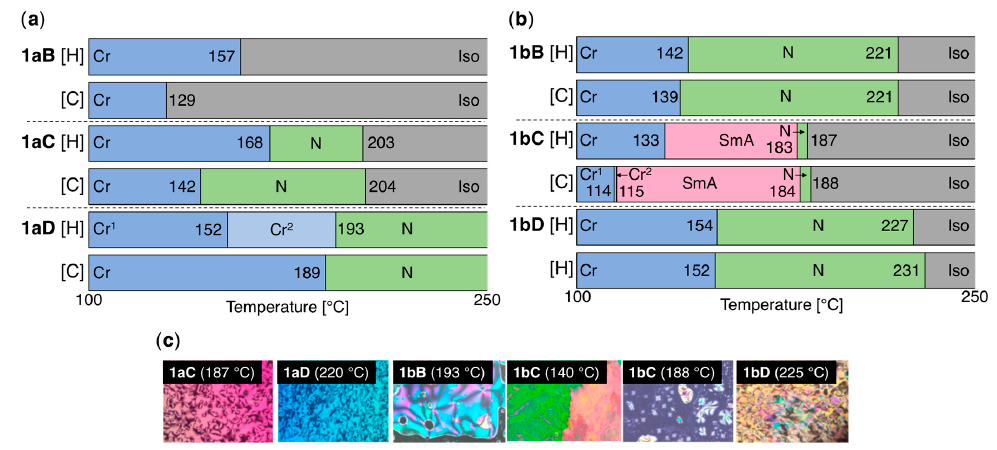
Figure 4. Phase transition behavior of ( a ) 1aB – D and ( b ) 1bB – D during the 2nd heating [H] and cooling [C] processes. Abbreviations: Cr, crystal; SmA, smectic A; N, nematic; and Iso, isotropic phases. ( c ) Microphotographic images recorded by POM during the cooling